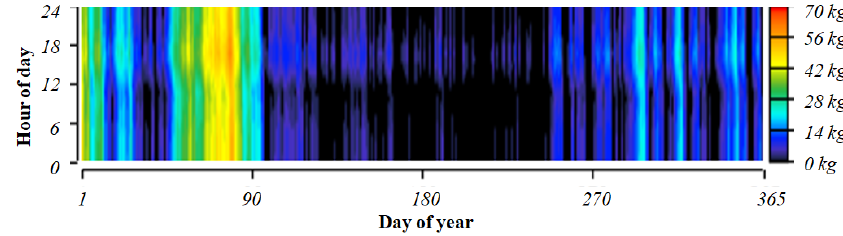
Figure A5. Hydrogen output from reformer in HEGS combination 3.